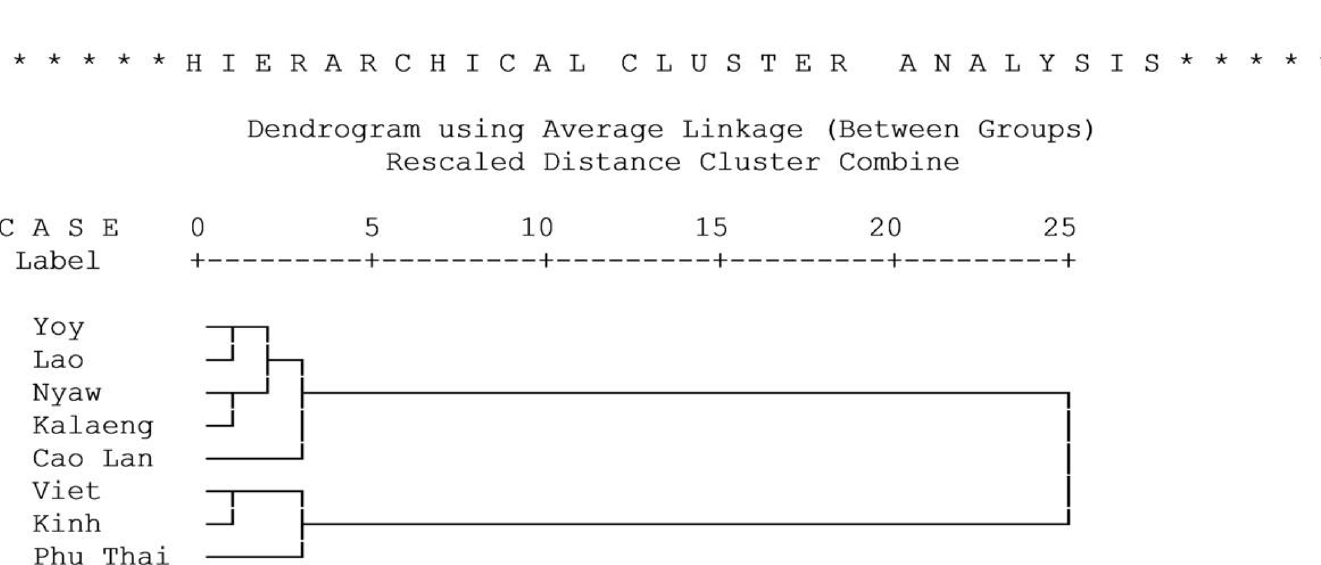
Fig 4. Comparison of modal structural patterns of homegardens of different ethnic groups in Northeast Thailand and Vietnam (% of gardens having characteristic).